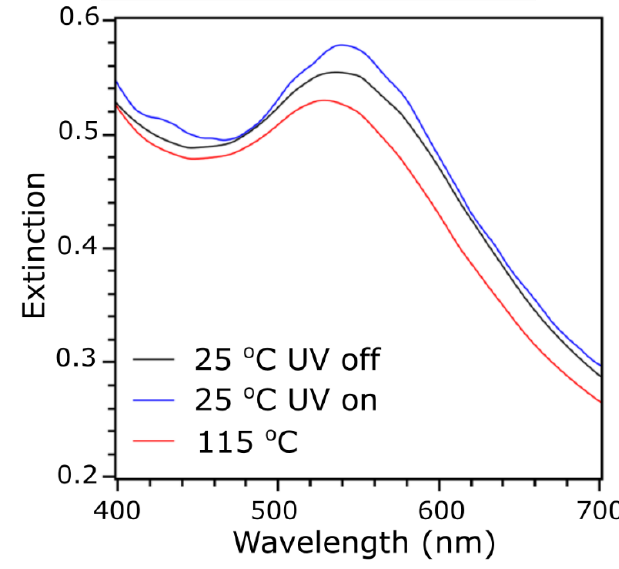
Figure 6. UV–VIS analysis of 5-L M L A material thermo- and photo- dependent plasmonic Figure 6. UV – VIS analysis of 5-L M L A material thermo- and photo- dependent plasmonic properties.